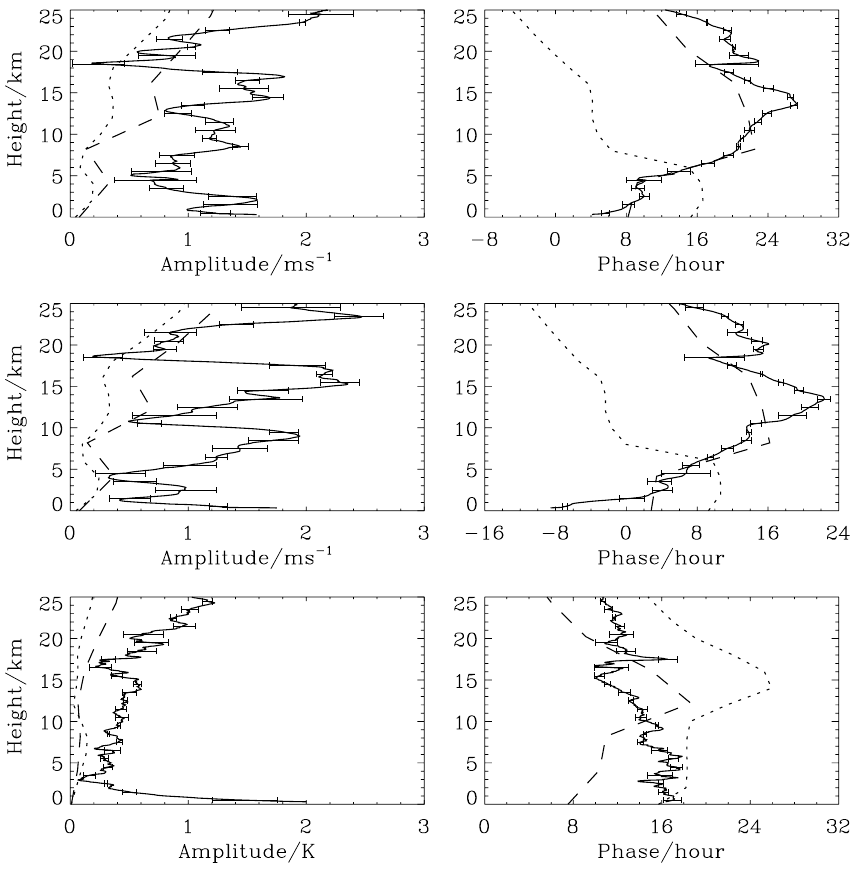
Fig. 6. The comparison between the amplitude and phase of the fitted diurnal tide in August 2006 (solid curve along with error bars), and those from the GSWM-00 (dotted) and GSWM-02 (dashed) in zonal wind (top), meridional wind (middle) and temperature